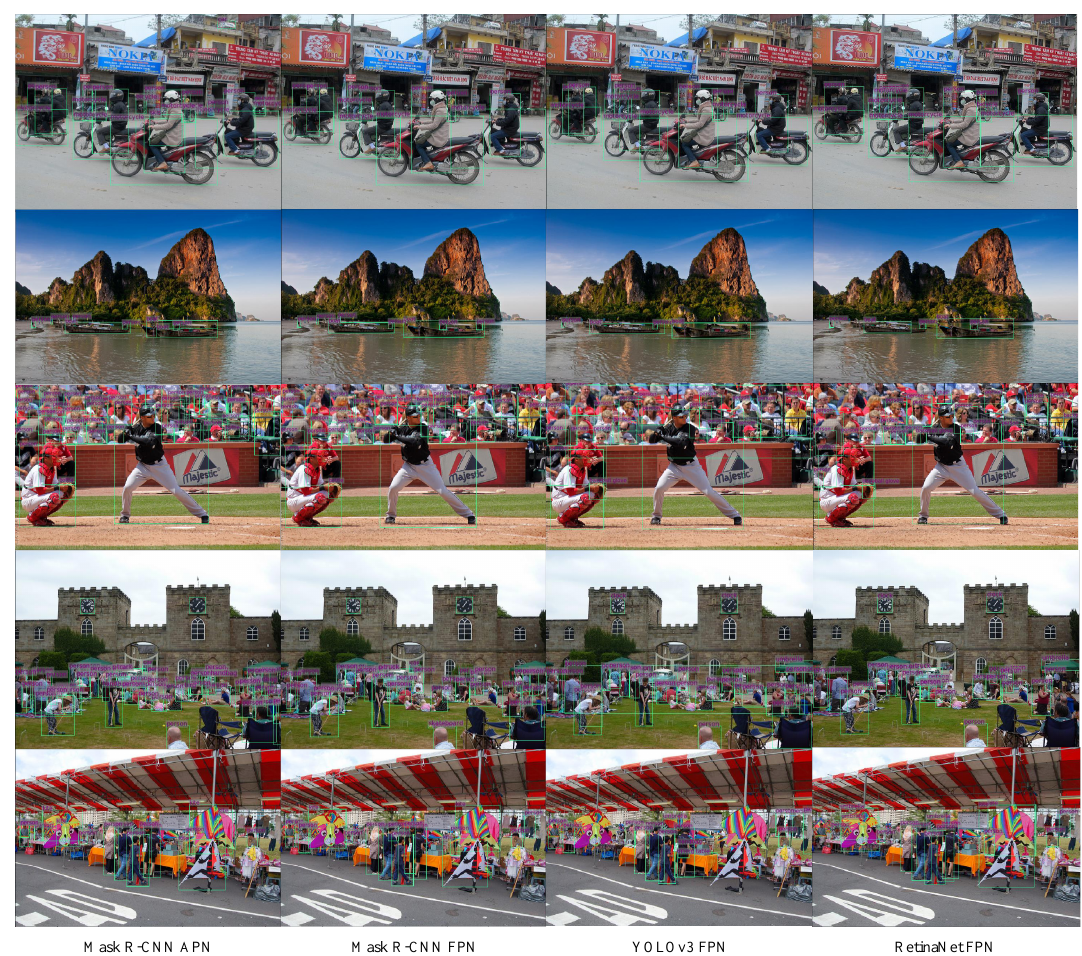
Figure 5. Selected examples from the MS COCO 2017 test dataset using our method and other methods using the FPN model.